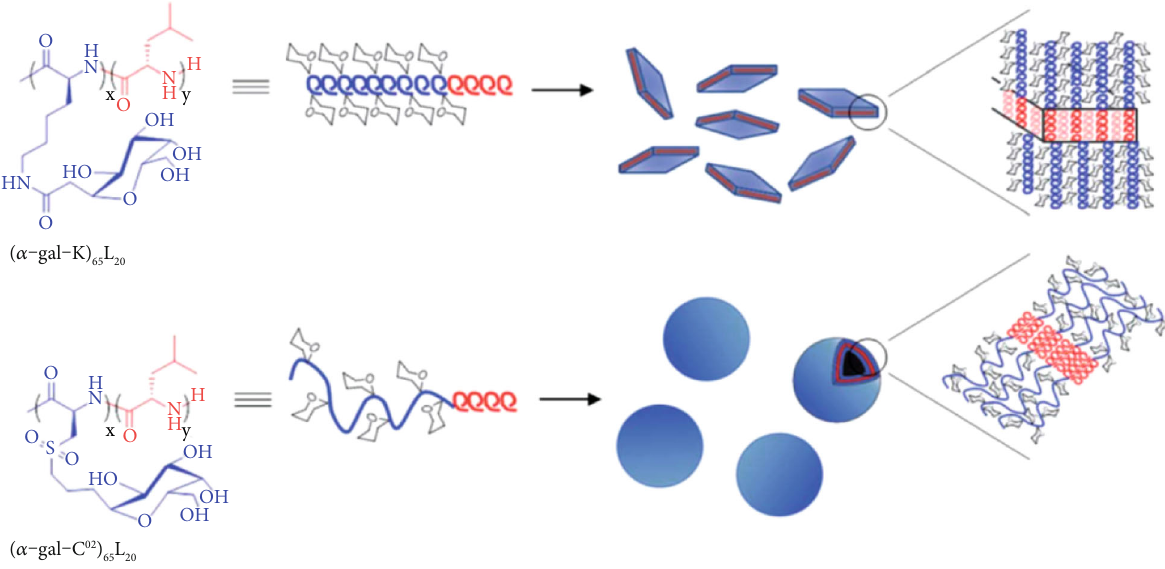
Figure 5: Schematic showing structures of amphiphilic glycosylated diblock copolypeptides and observed self-assemblies (reprinted with permission from Ref. [75]; copyright (2013) Royal Society of